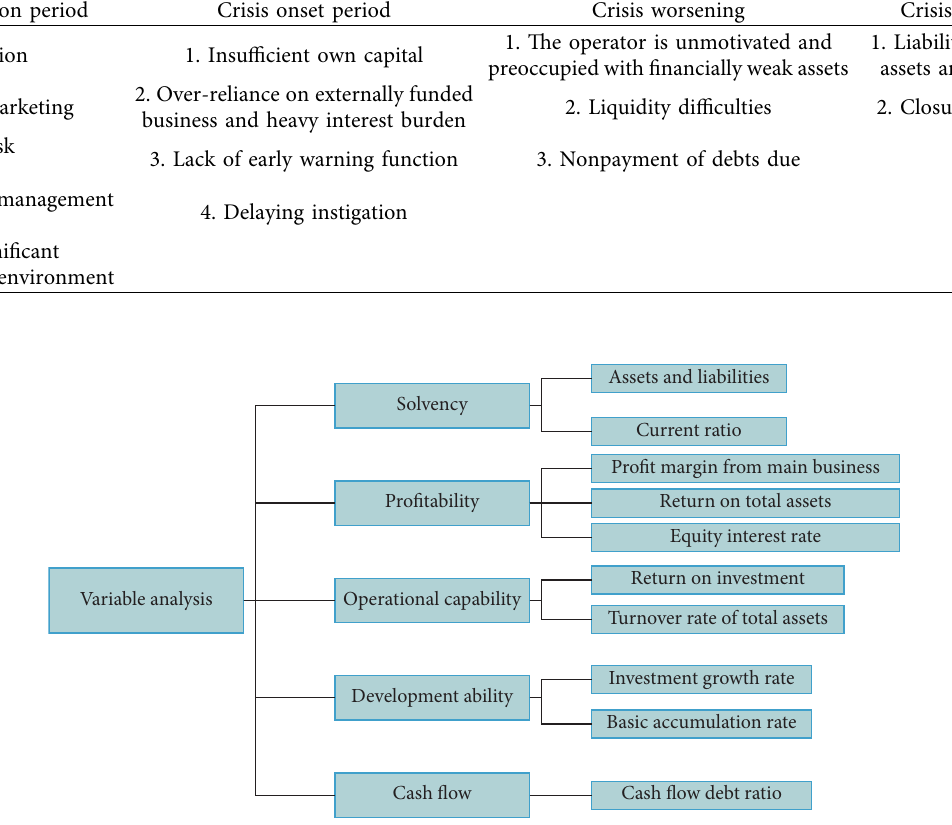
Figure 2: Variable analysis index